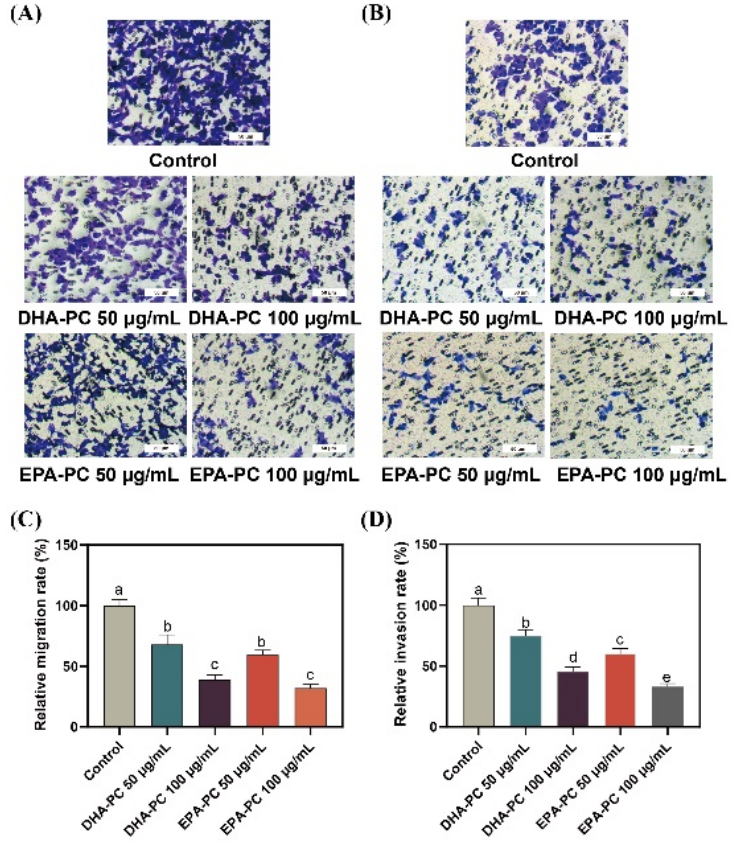
Figure 3. DHA-PC and EPA-PC suppressed the migration and invasion ability of 95D cells. ( A ) The migrated cells were photographed under the microscope (Scale bar: 50 µ m). ( B ) The invaded cells photographed were under the microscope (Scale bar: 50 µ m). ( C ) Quantitative analysis of migrating cells. ( D ) Quantitative analysis of invaded cells. Different letters (a, b, c, d, and e) indicate remarkable differences at p < 0.05 among all groups determined by ANOVA (Bonferroni’s test). 3.4. Effect of DHA-PC and EPA-PC on F-Actin Organization through the TGF- β Pathway The invasive and migration abilities of cancer cells are highly related to the cell cytoskeleton [26]. Therefore, the distribution of intracellular F-actin in 95D cells treated with DHA-PC or EPA-PC was investigated. After intervention with the DHA-PC or EPA-PC, intracellular F-actin staining became unclear, degraded, and fragmented versus